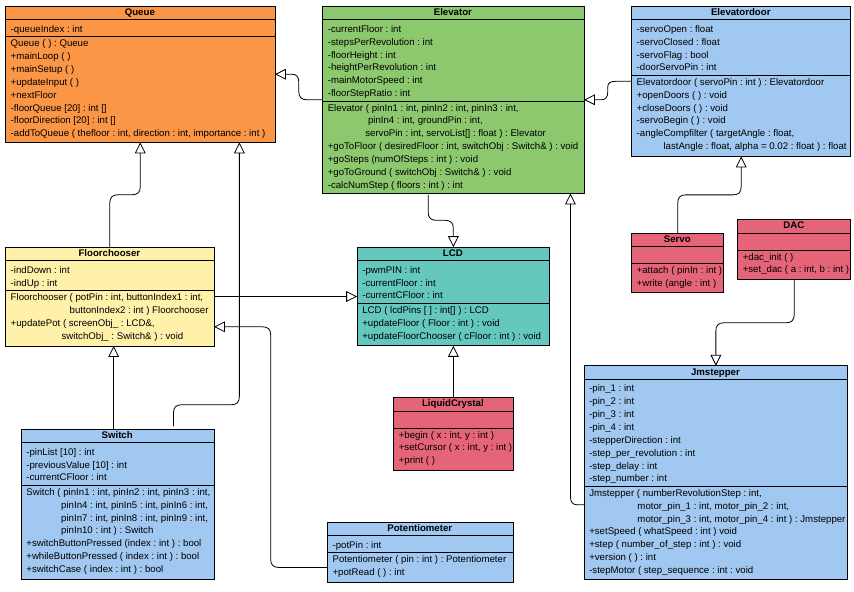
Visual Paradigm Online Free Edition Figure 7. UML Class Diagram for the elevator model.